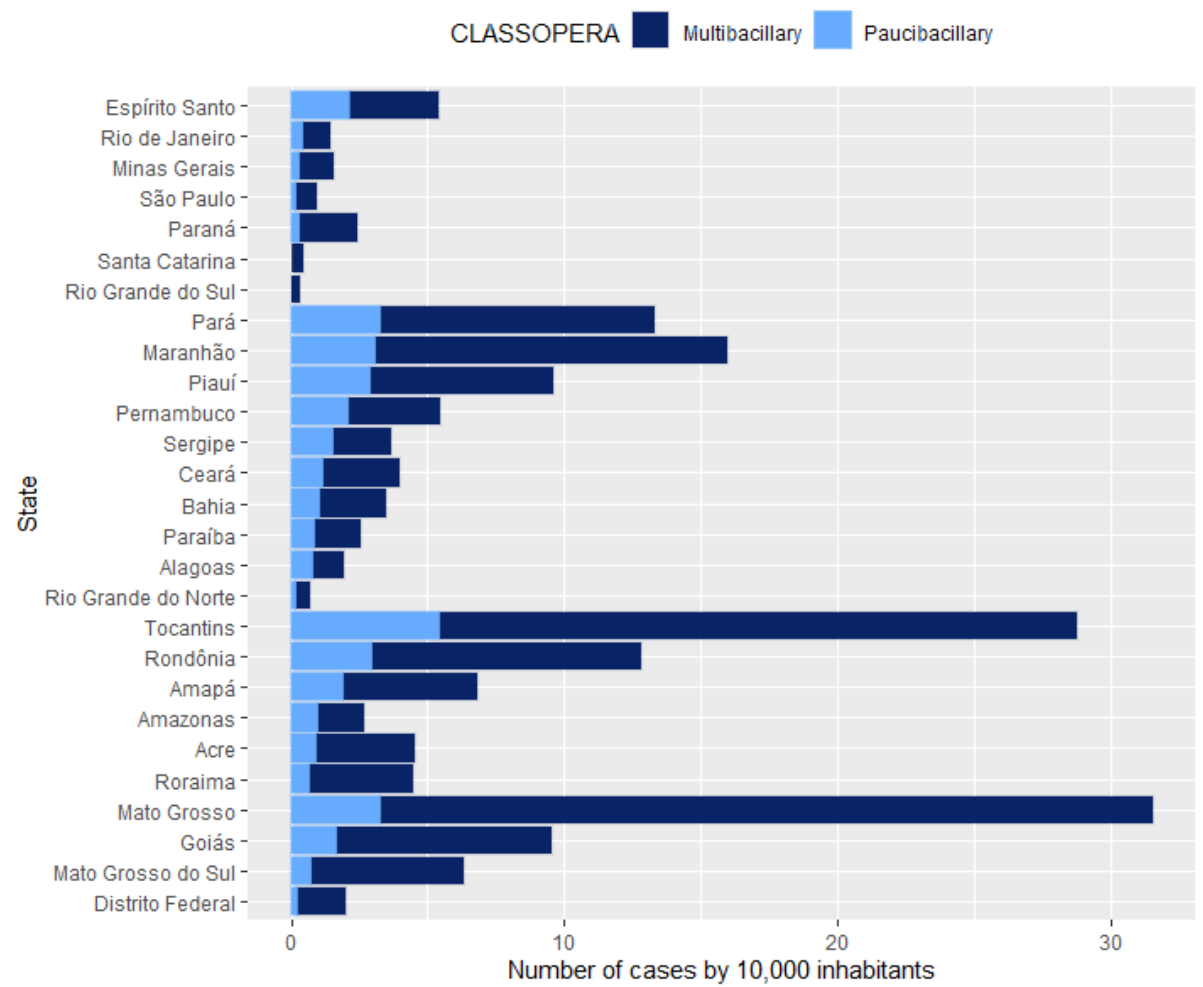
Figure 5. Distribution of leprosy cases in the Brazilian states from 2014 to